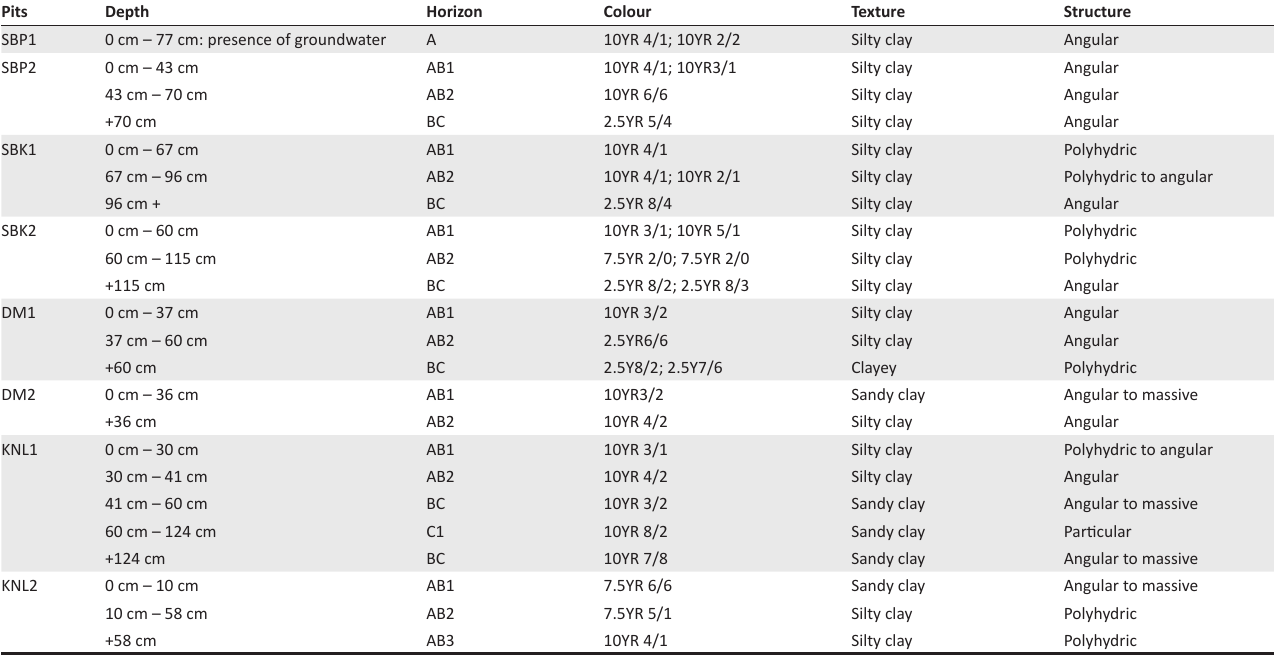
FIGURE 4: Comparison of the soil pH Basin and the Senegal River Valley. TABLE 3: Description of the soil profiles at SébiPonty, Sébikotane, Deni Malick and Keur Ndiaye Lo villages.